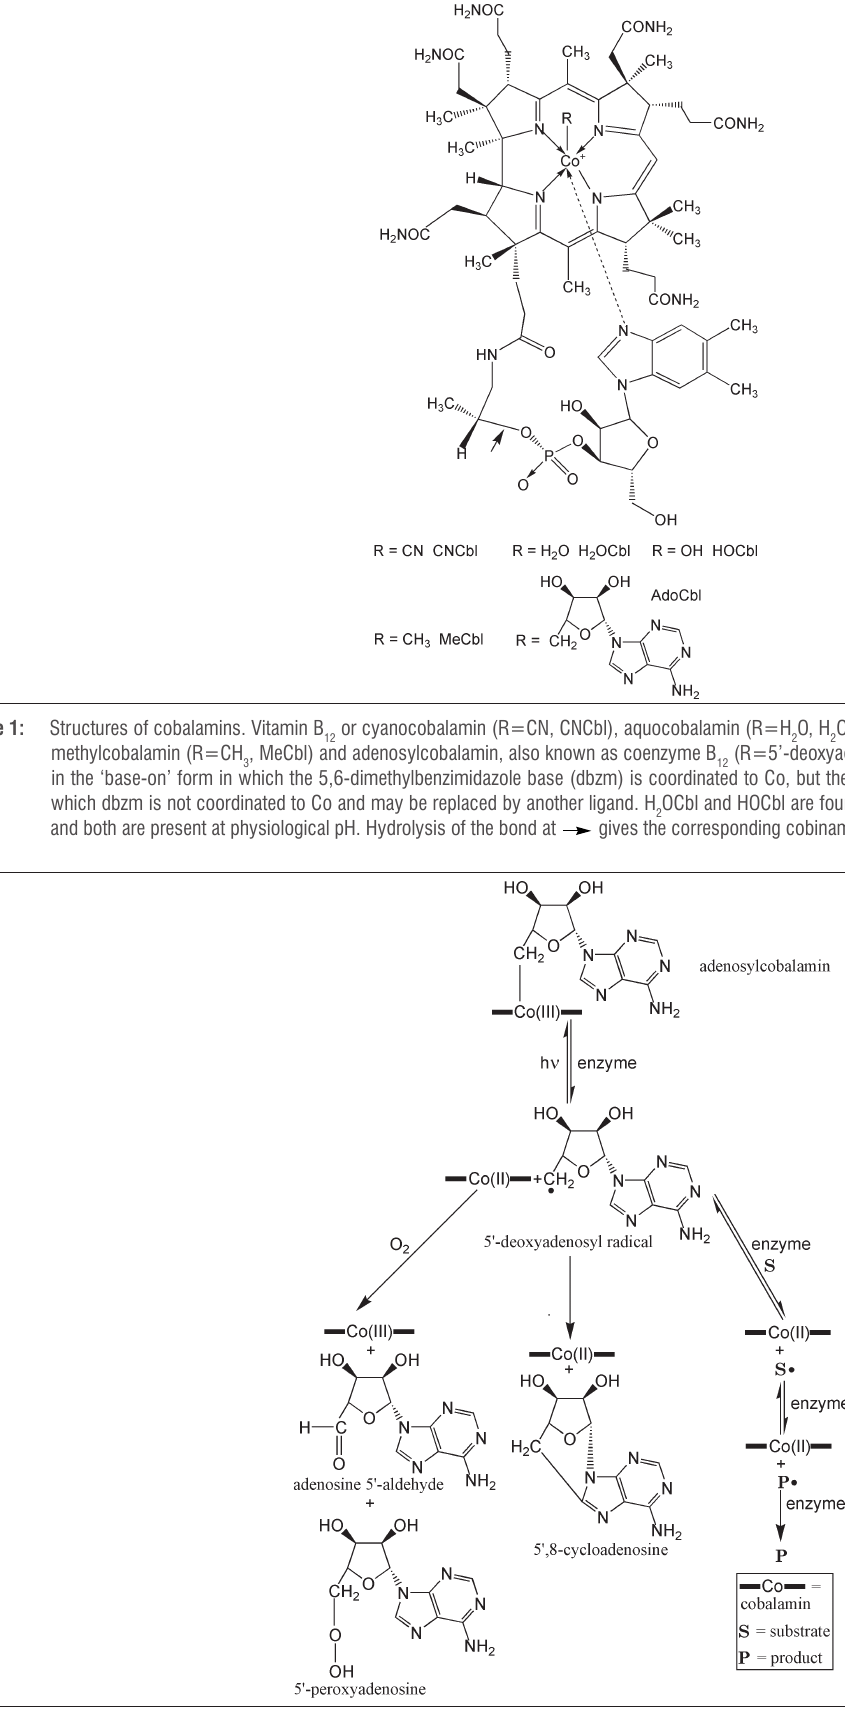
Scheme 1: Homolysis of the Co-C bond of adenosylcobalamin (AdoCbl).